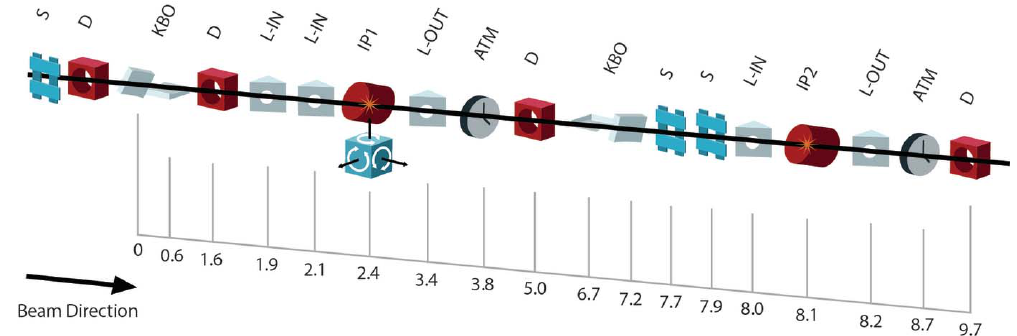
Figure 2 Schematic overview of the TMO instrument layout with distances. All distances are indicated in meters from the first mirror inside of TMO. Shown are scatter slits (S), diagnostics (D), KB optics (KBO), laser in-coupling (L-IN), interaction points (IP), laser out-coupling (L-OUT), and laser arrival time monitor